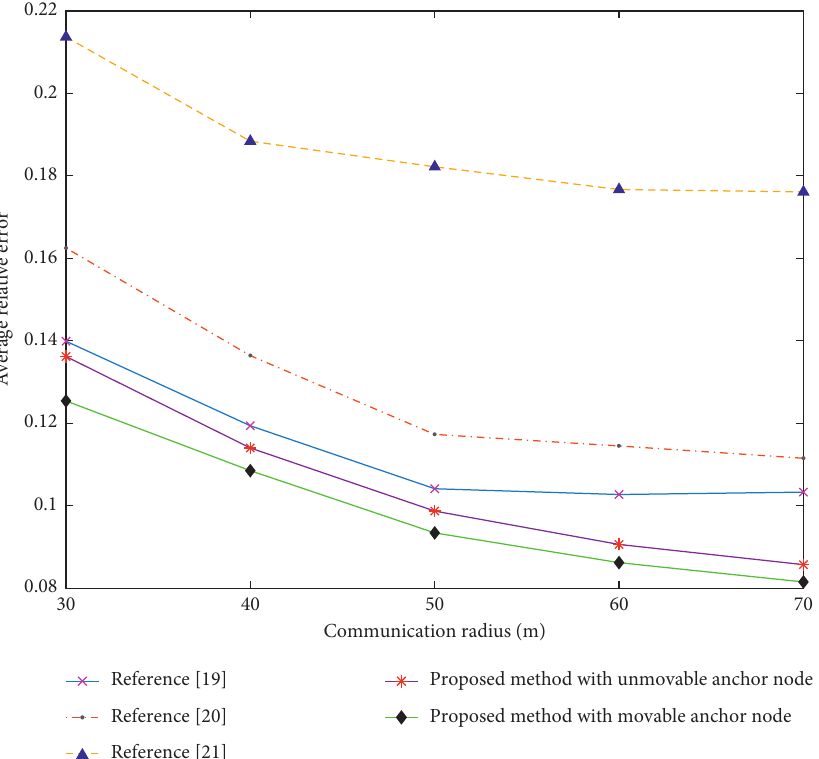
Figure 2: The average relative error with different communication